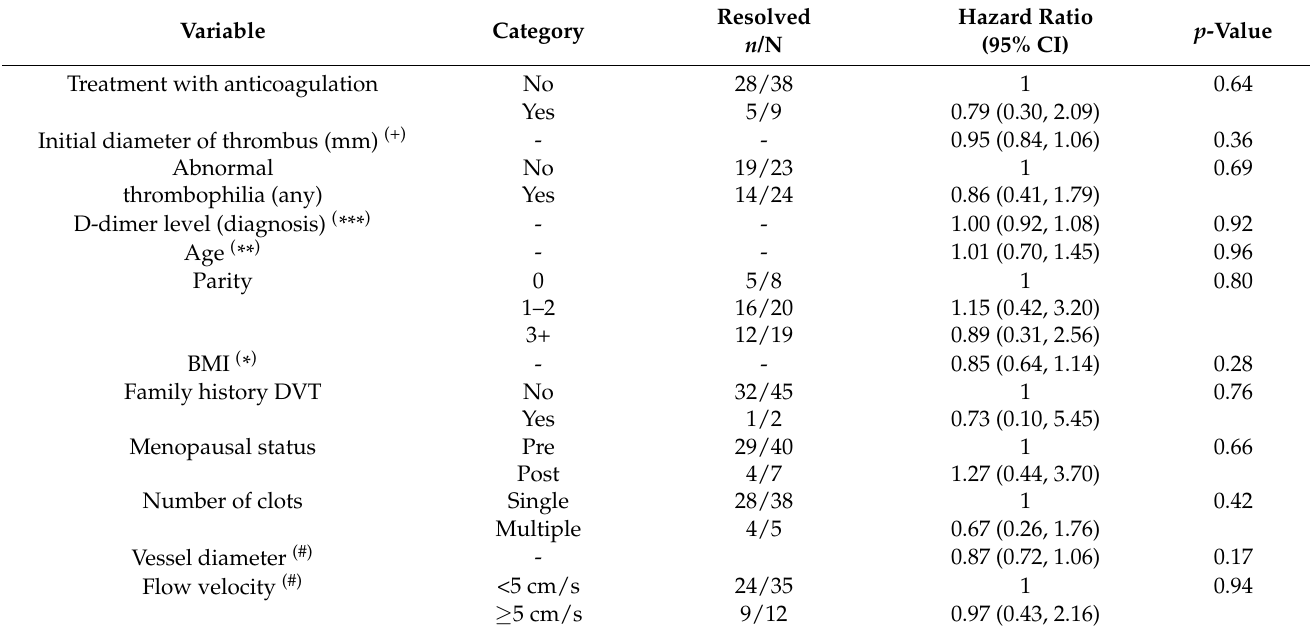
Table 3. Factors associated with clot